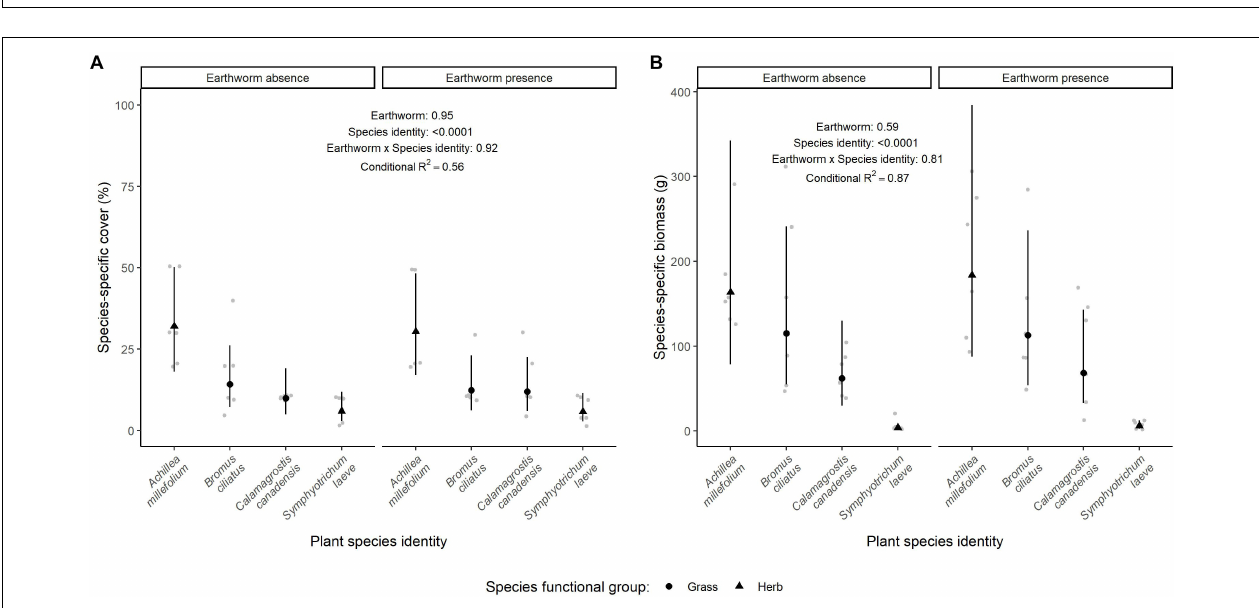
FIGURE 1 | Effect of earthworms on herbaceous community cover (A) , aboveground (B) , and belowground (C) biomass (mean ± sd). The p -values of the earthworm treatment are based on linear models. Number of observations per treatment: 6.